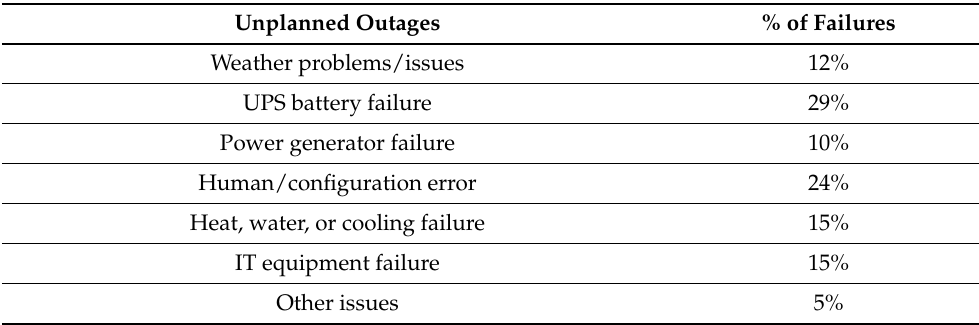
Table 1. Causes of Unplanned Outages in Data